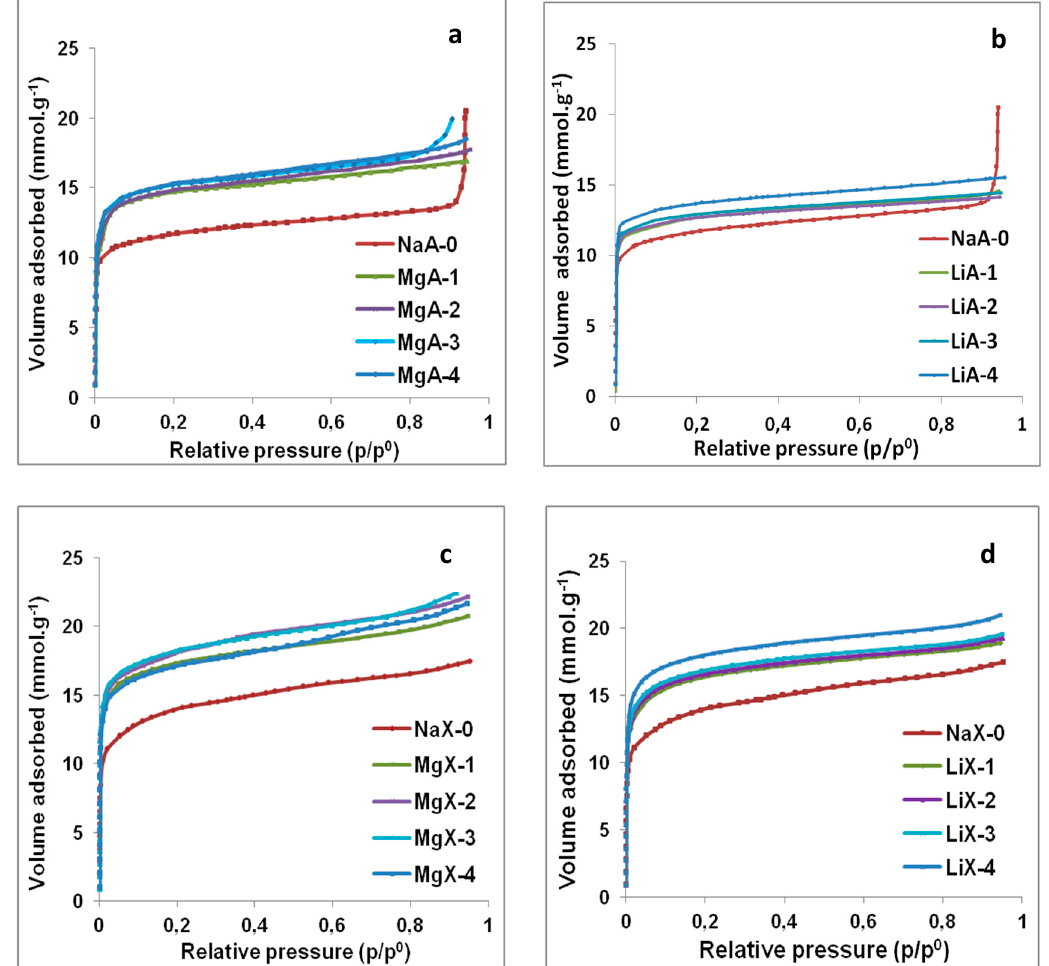
Figure 10. Water adsorption isotherms for raw and Mg 2+ exchanged LTA ( a ) and FAU ( c ) type zeolites and Li + exchanged LTA ( b ) and FAU ( d ) type zeolites.